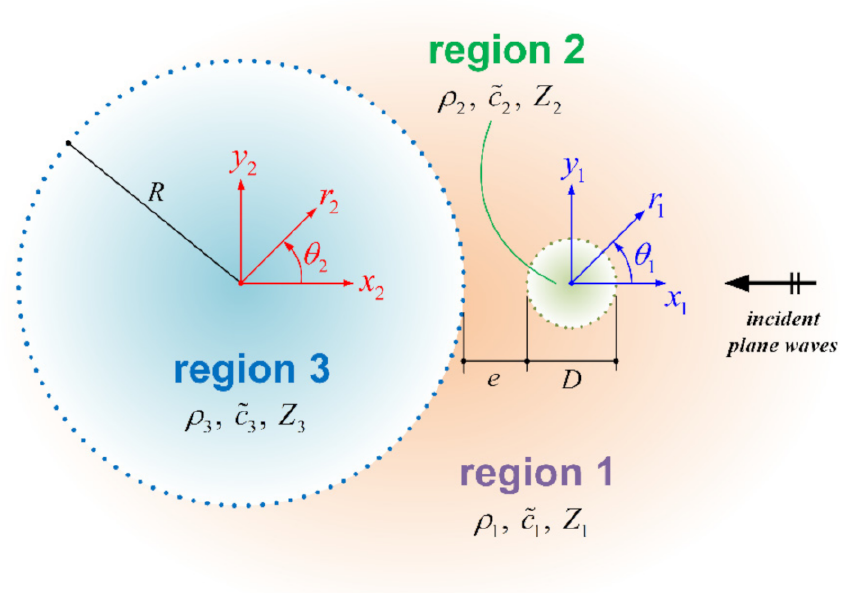
Figure 2. Geometric layout of the mixture model for ultrasound